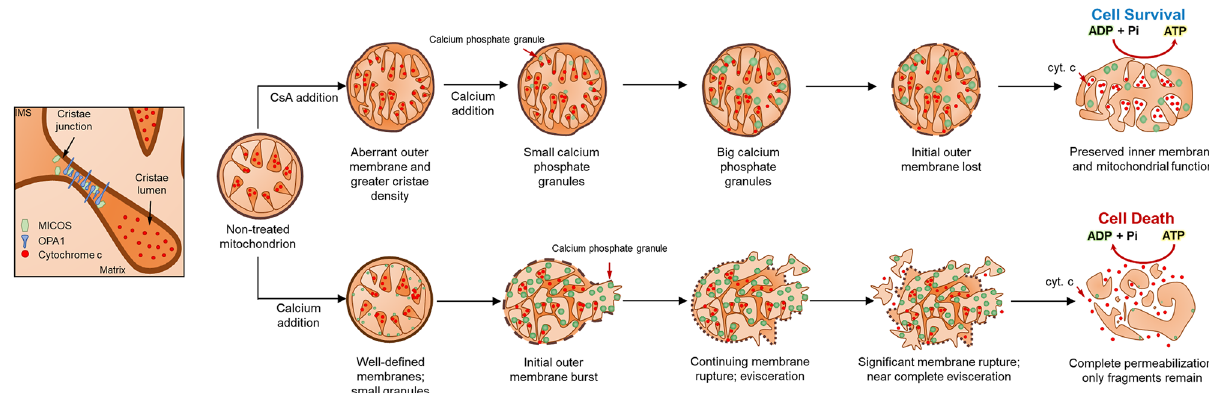
Figure 8. Schematic representation of calcium overload leading to mitochondrial fragmentation and permeabilization. In energized mitochondria, the mitochondrial membrane potential creates the driving force for calcium to accumulate in the mitochondrial matrix. The accumulation and growth of these complexes induces mitochondrial swelling that leads to outer membrane rupture, inner membrane fragmentation and cyt. c release. This causes membrane potential dissipation and induces the calcium-phosphate complex disassembly. CsA, however, alters the membrane morphologies and allows for robust calcium uptake after the addition of a calcium bolus. The inner mitochondrial membrane remains tethered and the cristae junctions intact. This avoids cyt. c remodeling and preserves the bioenergetic status despite the calcium effects on mitochondrial respiration. The drawing was created with Microsoft PowerPoint for Microsoft 365 MSO (16.0.13231.20250)